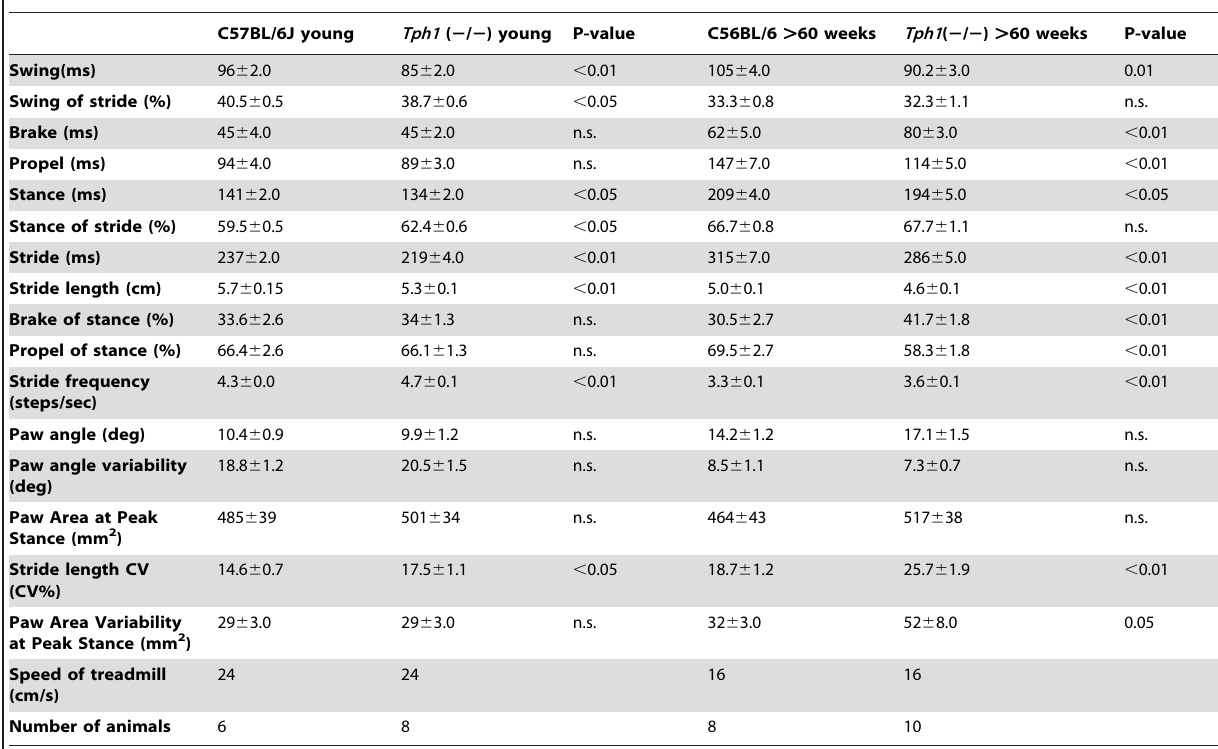
Table 1. Tph1 ( 2 / 2 ) mice demonstrate alterations in gait